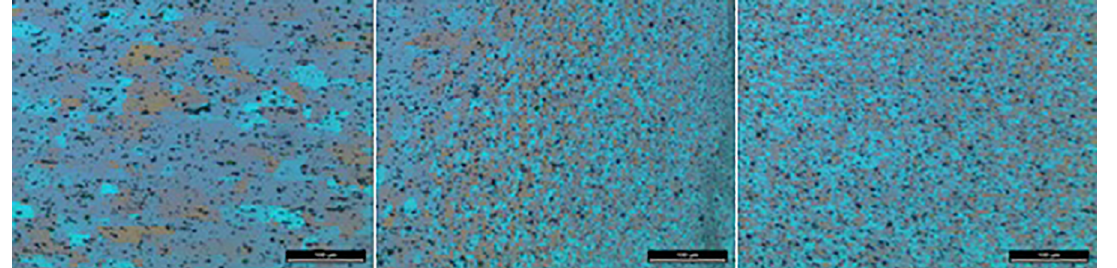
Figure 3. Grain structures in different microstructural zones (a) BM, (b) TMAZ, (c) SZ.